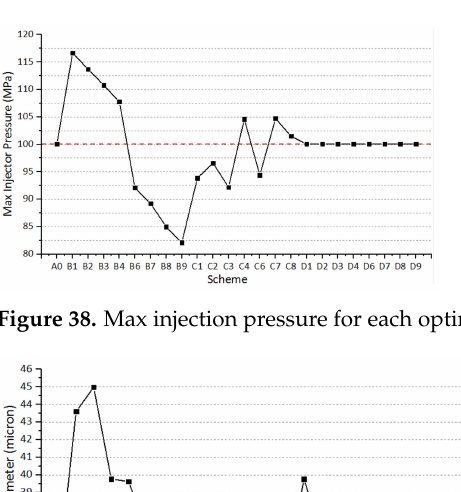
Figure 37. Injection start and end timings for each optimized case.